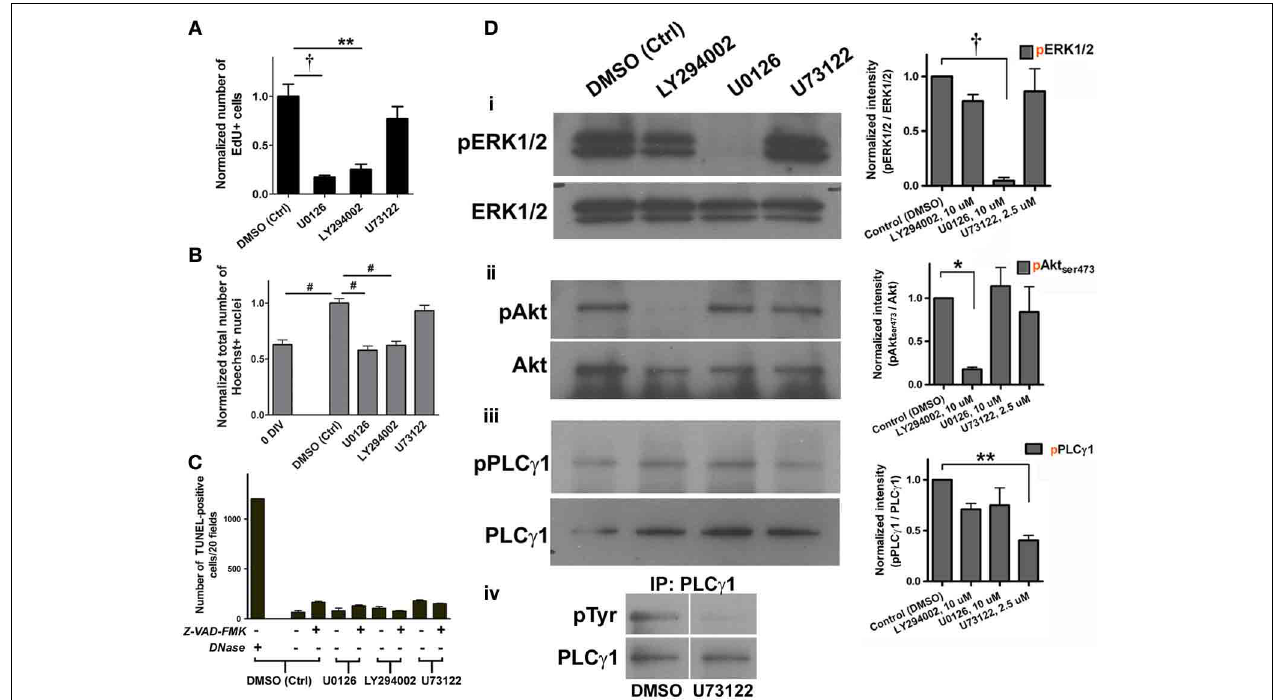
FIGURE 3 | Cell proliferation in adult spinal cord NSPC cultures requires activation of ERK1/2 and Akt. (A) Quantification of the normalized number of EdU + cells showed that inhibition of ERK1/2 (with MEK inhibitor, U0126, 10 μ M) and Akt (with PI3K inhibitor, LY294002, 10 μ M) activation suppressed proliferation of adult spinal cord cells at 4DIV; inhibition of PLC γ activation (with U73122, 2.5 μ M) had no effect (10 random fields with a 40 × objective per coverslip were analyzed, n = 3 coverslips; ∗∗ P < 0 . 01, † P < 0 . 001, One-Way ANOVA Bonferroni’s multiple comparison post-test). EdU was added to culture medium 6h before fixation. (B) Normalized total number of Hoechst-stained nuclei to the DMSO control grouped showed that inhibition of both ERK1/2 and Akt activation decreased total number of cells at 4–6DIV ( n = 9 coverslips, except LY294002: n = 8 coverslips, and U73122: n = 6 coverslips, from three experiments; # P ≤ 0 . 0001, One-Way ANOVA Bonferroni’s multiple comparison post-test). All values were normalized to the DMSO control group in each experiment. (C) Quantification of the number of TUNEL-positive cells at 4DIV to determine cell survival after treatment with